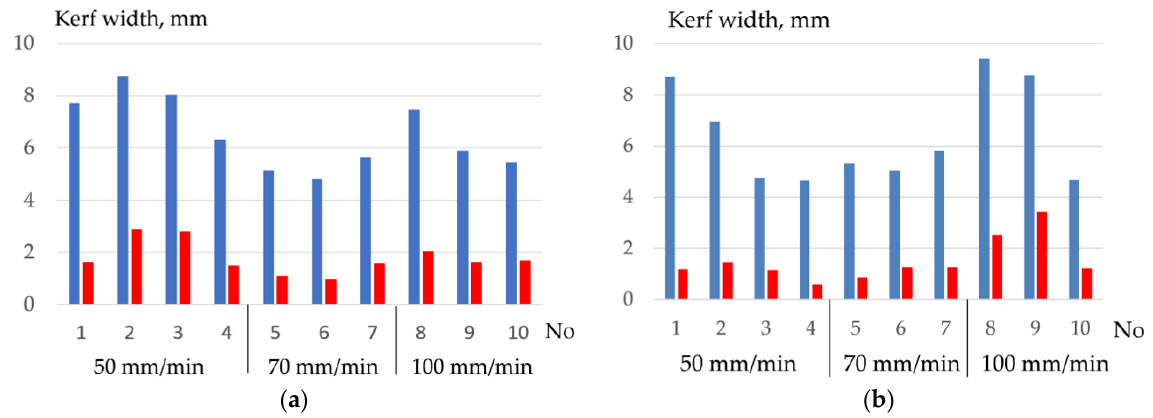
Figure 19. Variation of the average cutting width and deviations when cutting 10 KhSND steel at speeds of 50, 70, and 100 mm/min: ( a ) PPR-APL1-1 flux-cored wire; ( b ) PPR-APL1-2 flux-cored wire.